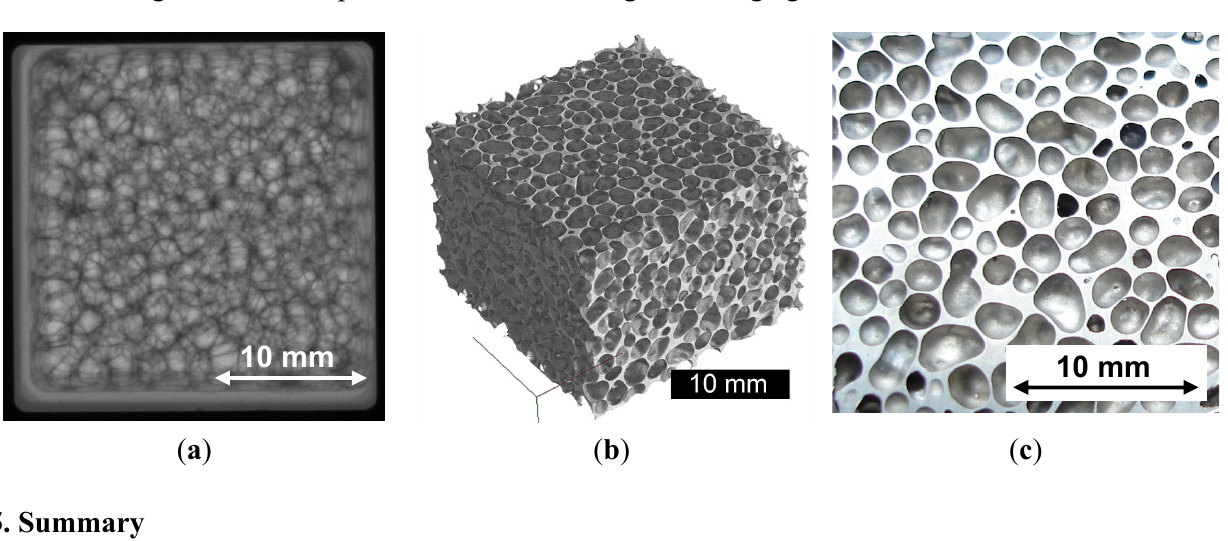
Figure 7. ( a ) In-situ X-ray radiography; ( b ) tomography and ( c ) photograph of a section of an AlMg15Cu10 foam produced without adding a blowing